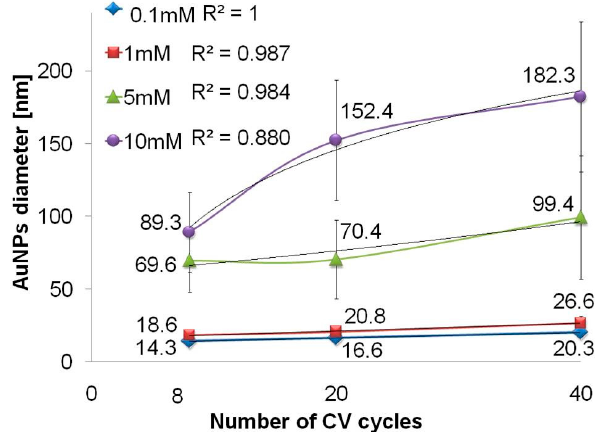
Figure 6. The average values of AuNPs diameters deposited in HAuCl 4 solution of concentration of 0.1 mM, 1 mM, 5 mM, and 10 mM in different number of cycles (8, 20, and 40). Bars represented a standard deviation, R 2 —correlation coefficient. Table 3. The average values of EDS analysis, diameter of gold nanoparticles and OCP (n = 3) with SD measured for annealed TNT arrays after deposition of AuNPs using CV method carried out in 0.1 mM, 1 mM, 5 mM, and 10 mM HAuCl 4 for di ff erent number of cycles (8, 20, 40).